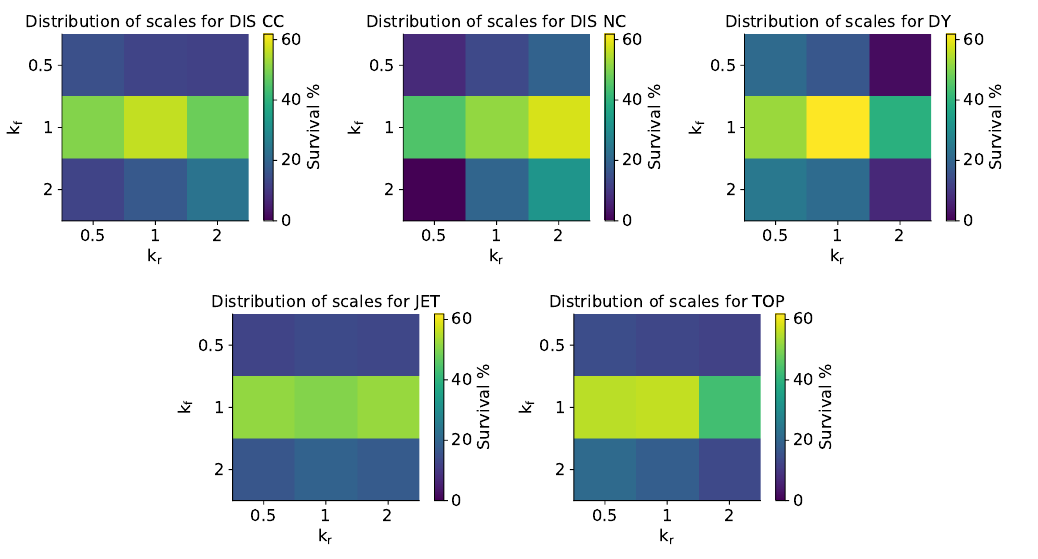
Figure 3 . The percentage of surviving replicas after postfit relative to the MCscales uniform prior for all scale combinations.